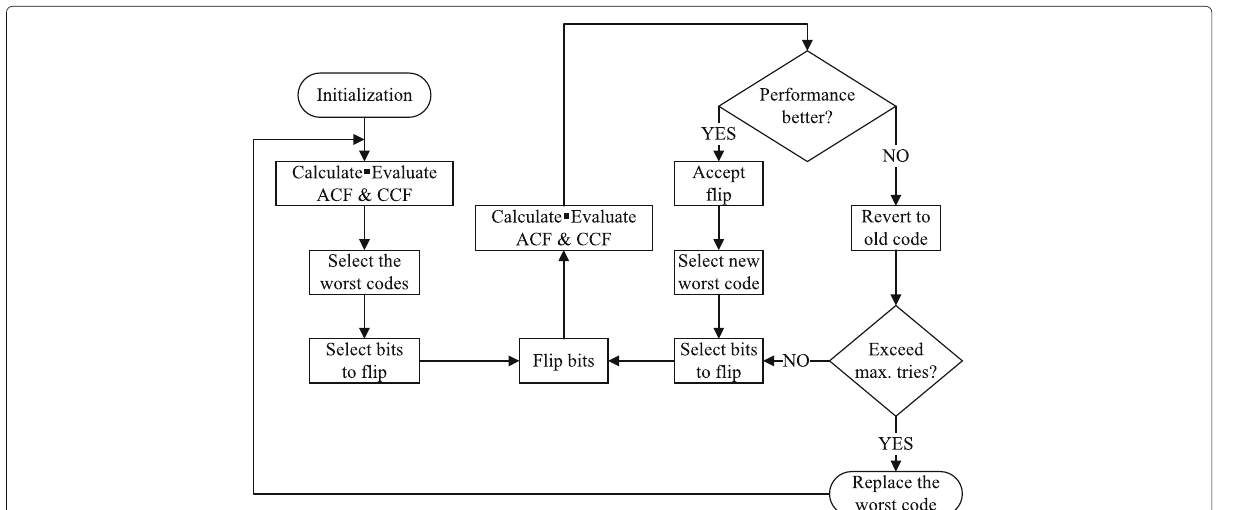
Fig. 7 The flowchart for optimization of Random